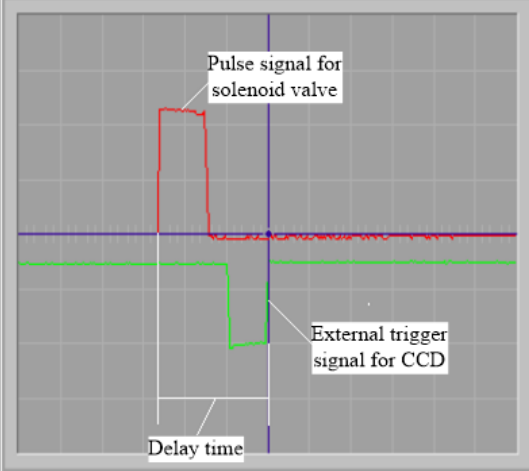
Figure 5. Pulse signal for solenoid valve and external trigger signal for charge-coupled device (CCD).